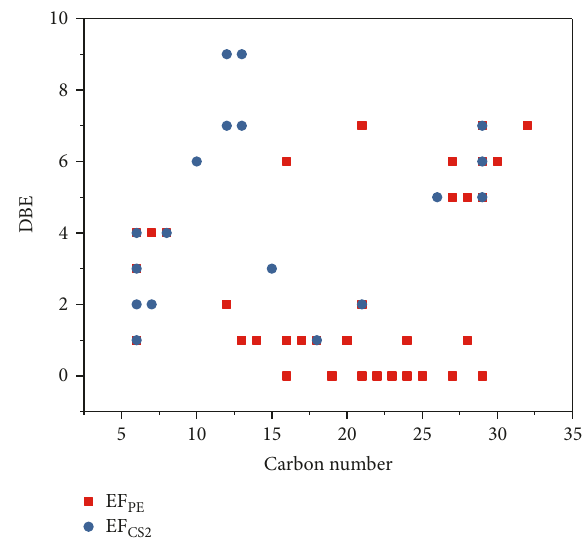
Figure 4: The relationship between DBE and carbon number for compounds identified in EF PE and EF CS 2